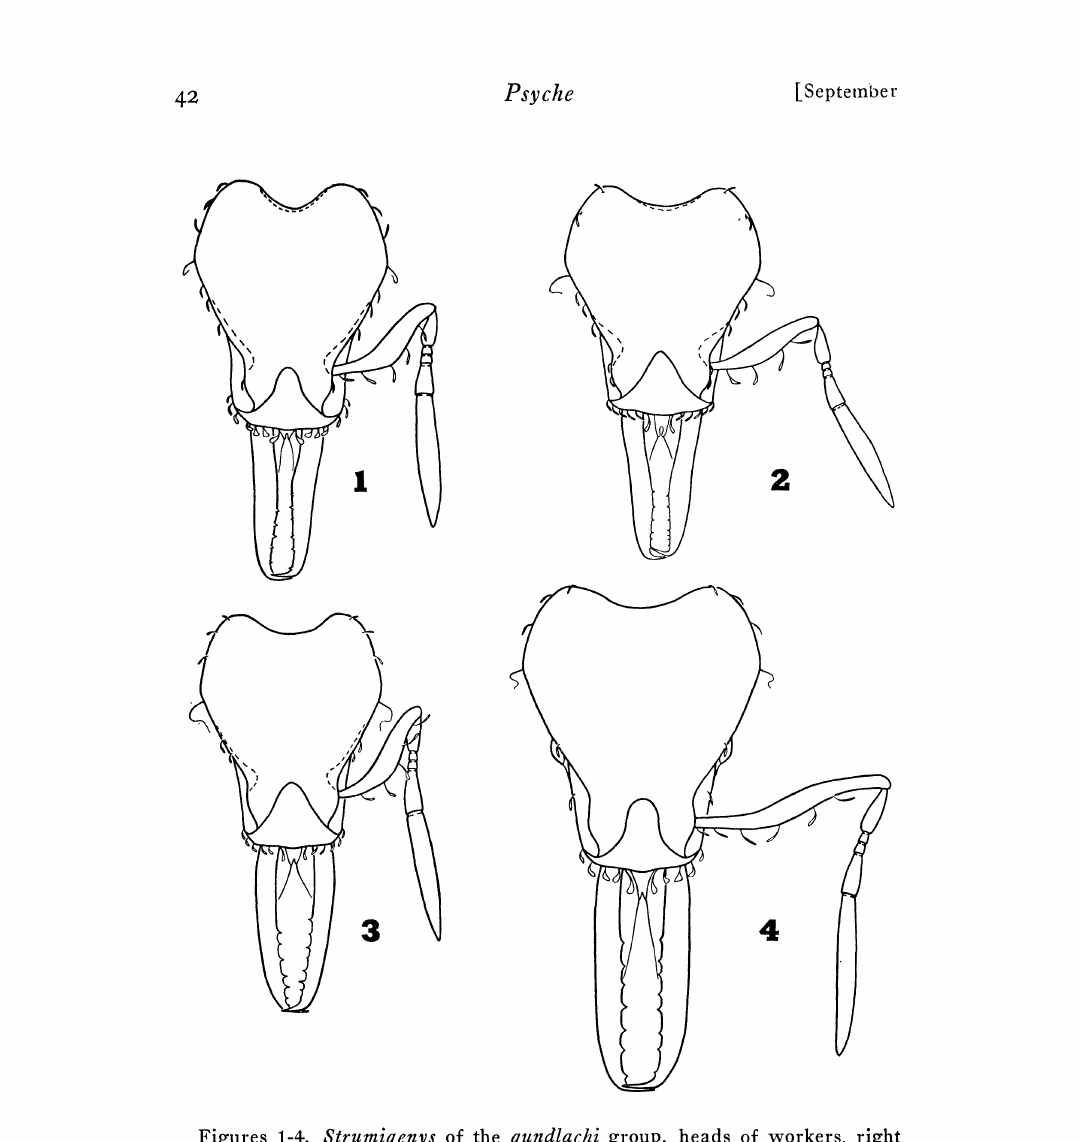
Figures 1-4. Strumigenys of the gundlachi group, heads of workers, right antenna omitted; only the fringing pilosity is shown, and mandibular hairs are omitted. Figure 1, S..qundlachi (syntype of the synonymous S. eggersi infuscata from Cuba). Figure 2, S. eggersi from S. Teresa, Espiritu Santo, Brazil. Figure 3. S. denticulata from Trinidad. Figure 4. S. jamaicensis, paratype. Drawn to same